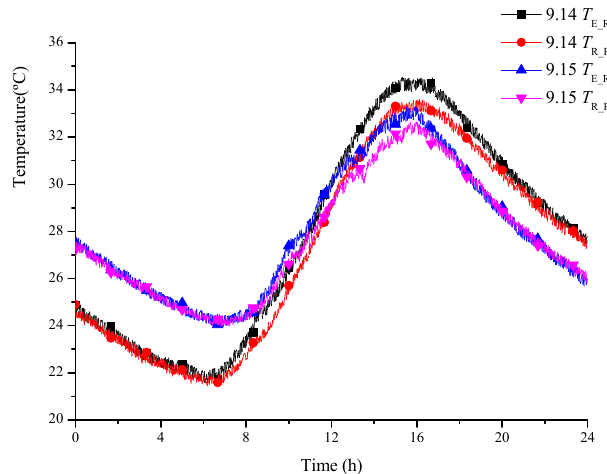
Figure 5. Indoor air temperature comparison between 14 and 15 September (insulation wall test system).